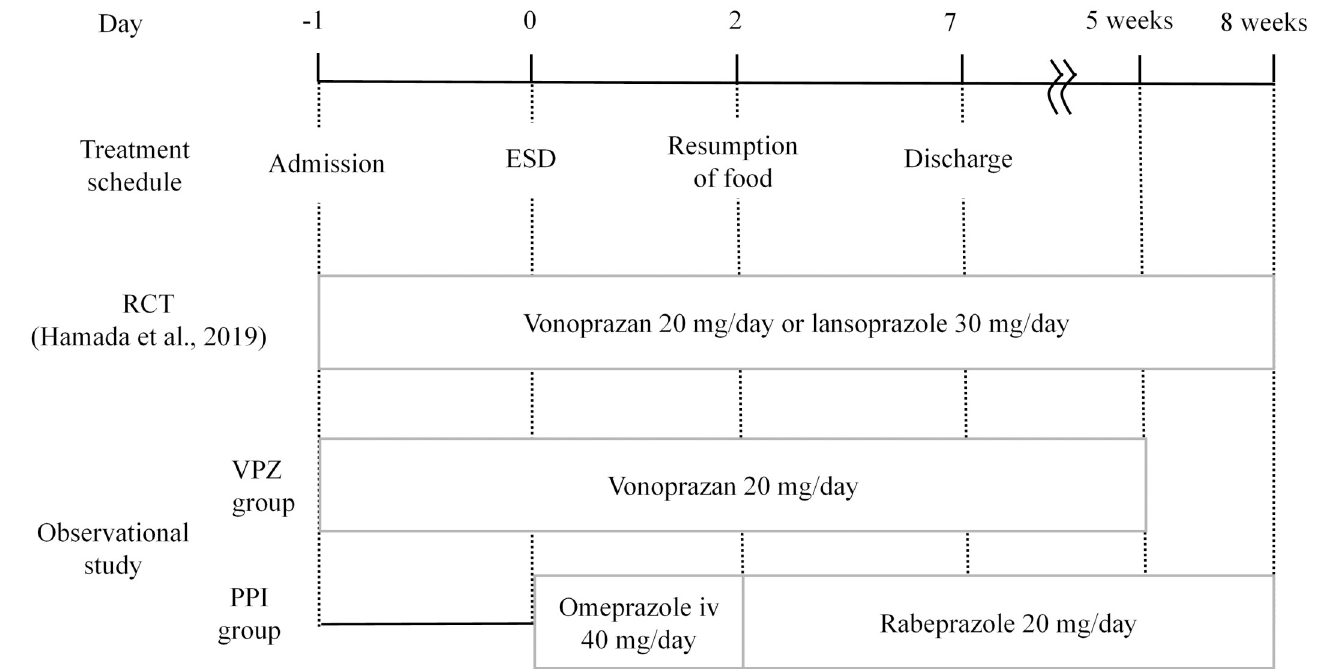
Fig 2. Treatment schedules of the randomized clinical trial and observational study. RCT, Randomised controlled trial; ESD, Endoscopic submucosal dissection; VPZ, Vonoprazan; PPI, Proton pump inhibitor; iv, Intravenous.